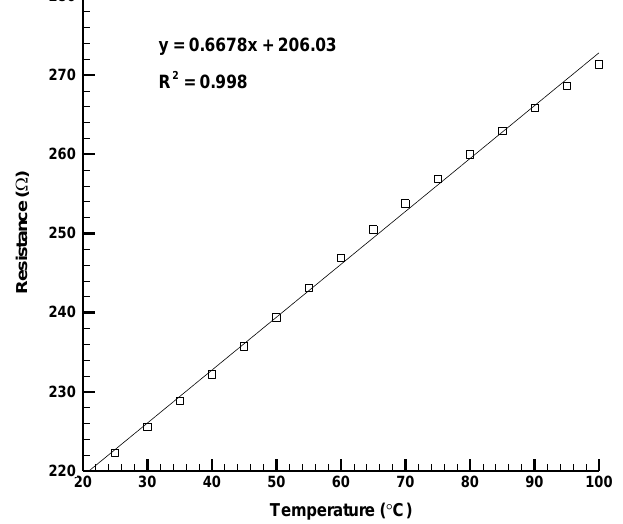
Figure 5. Resistive temperature microsensor performance.